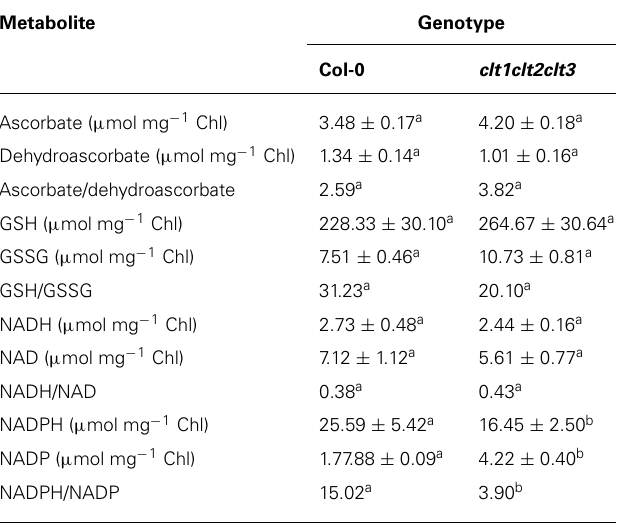
Table 1 |A comparison of the major redox metabolites in the rosette leaves of the clt1clt2clt3 triple mutants and wild-type (Col-0) plants. Metabolite Genotype Col-0 clt1clt2clt3